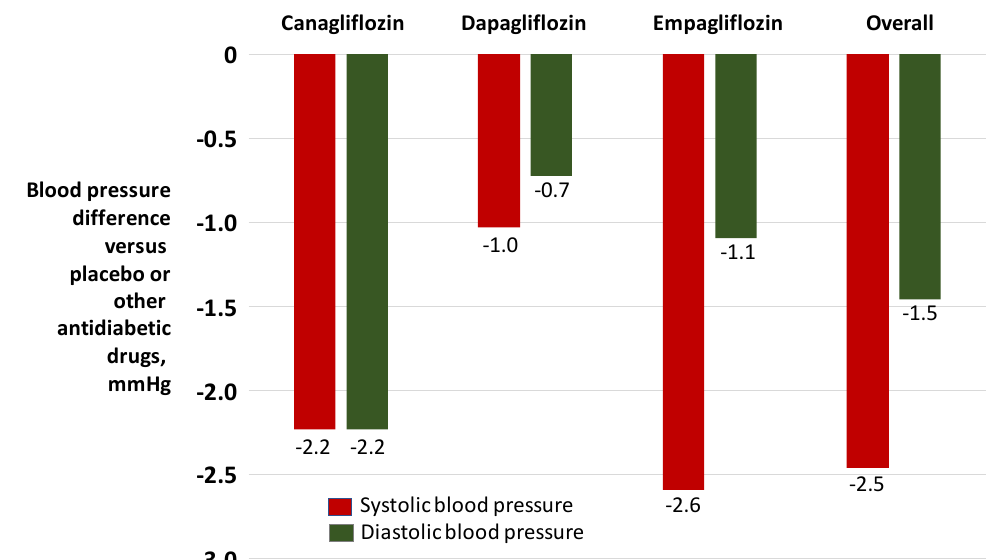
Figure 1. Blood pressure lowering effects of sodium-glucose cotransport-2 inhibitors on blood pressure in patients with diabetes mellitus. Adapted from Mazidi and coworkers [78].